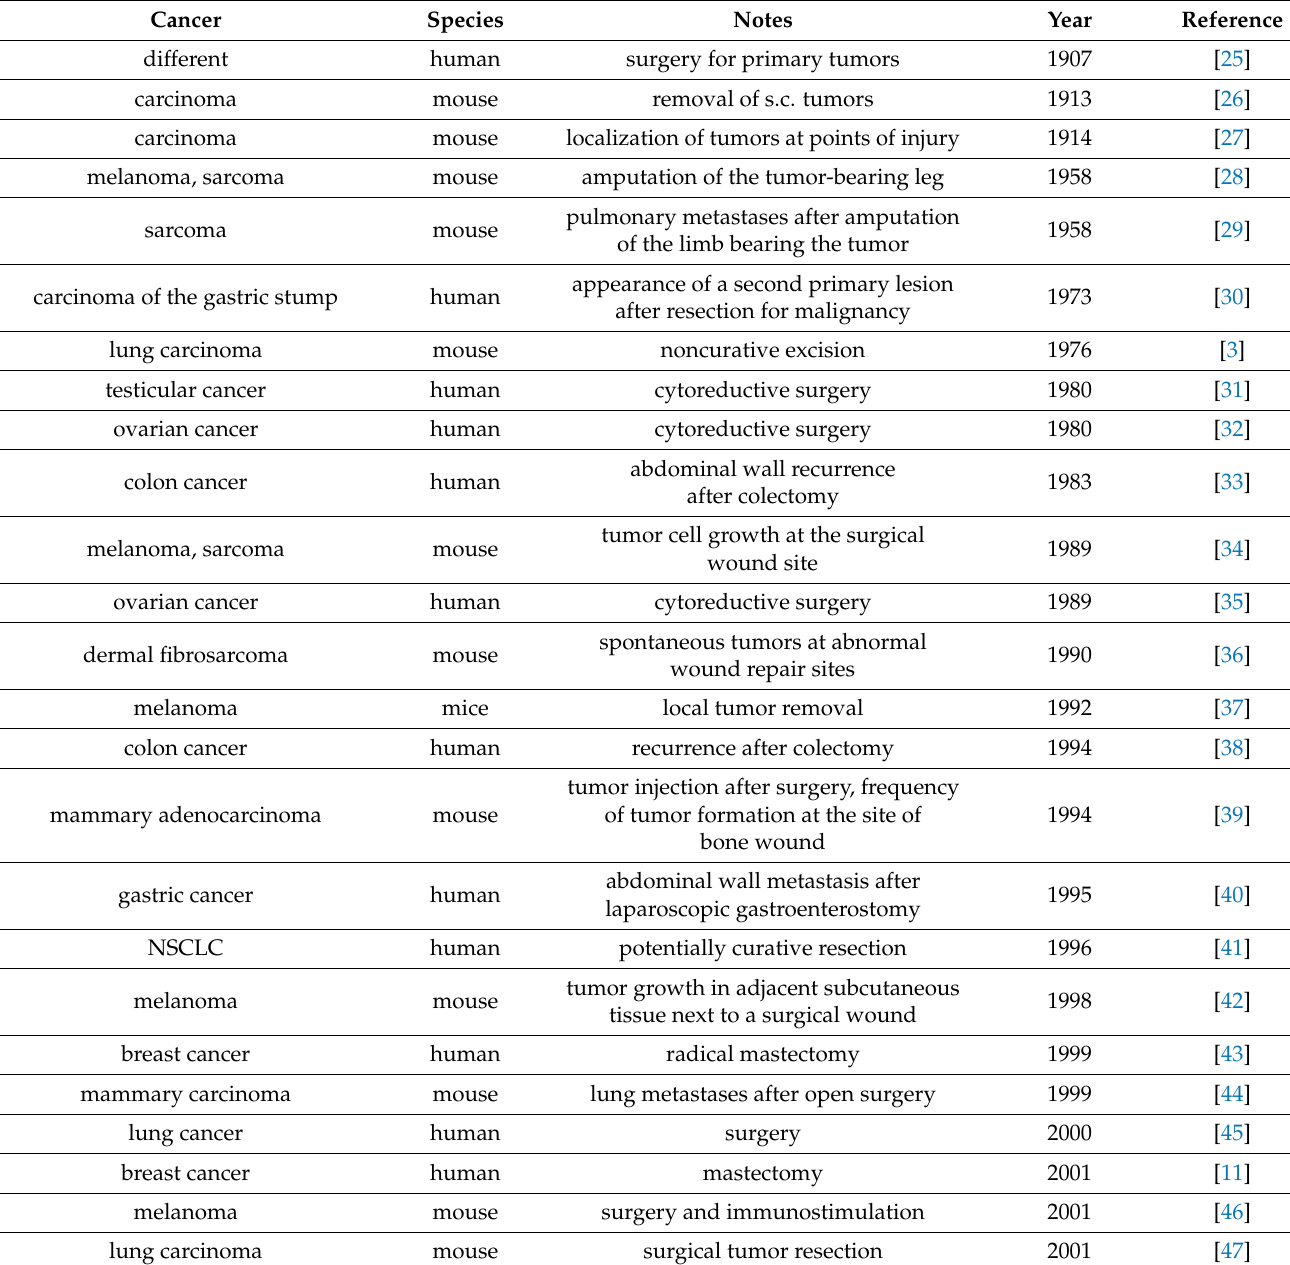
Table 1. Observations of accelerated postoperative metastatic tumor